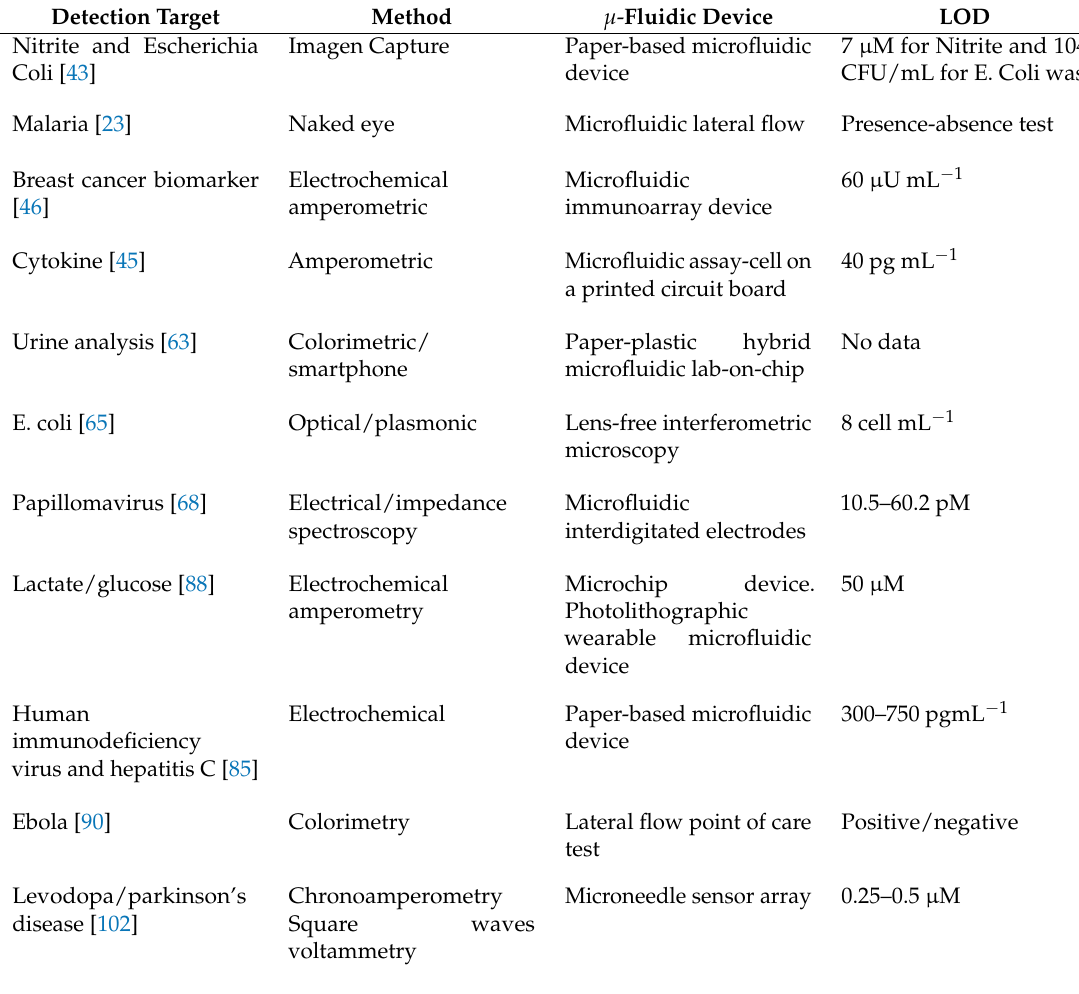
Table 1. List of microfluidic devices reported in the literature to detect various analytes and diseases. Also given are the methods of detection and the limits of detection